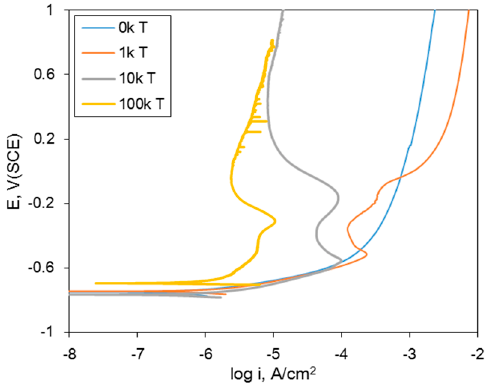
Figure 2. Effect of addition of a single corrosion inhibitor on the anodic polarization curve of DCI in deaerated [tap water + x ppm tungstate (T)] at 30 °C.